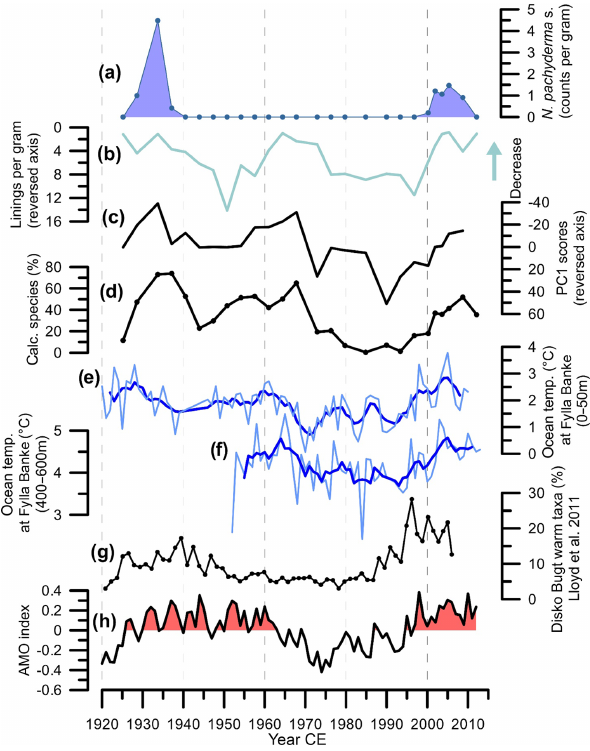
Figure 7. Comparison of results from this study of core POR13- 05 (a–d) with climate records (e, f) and reconstructions from West Greenland (g) and the Atlantic Multidecadal Oscillation (h) . (a) Abundance of N. pachyderma (sinistral) (countsg − 1 ). (b) Num- ber of organic linings per gram. (c) Scores of PC1 based on analysis of species abundances. (d) Percentage of calcareous foraminifera. (e) Water temperatures (0–40m, June) measured from trawl surveys at Fylla Banke; data before 1950 were extended back to 1861, based on observations from a wider area (Ribergaard et al., 2008). Dark blue line indicates the 3-year running average. (f) Measured temper- atures at Fylla Banke (400–600m) (Ribergaard et al., 2008). Dark blue line indicates the 3-year running average. (g) Percentage of At- lantic water indicators from a benthic foraminifera study in Disko Bugt, West Greenland (Lloyd et al., 2011). (h) The AMO index is based on the definition by Enfield et al. (2001). Stippled lines are a visual aid for comparing the different records.